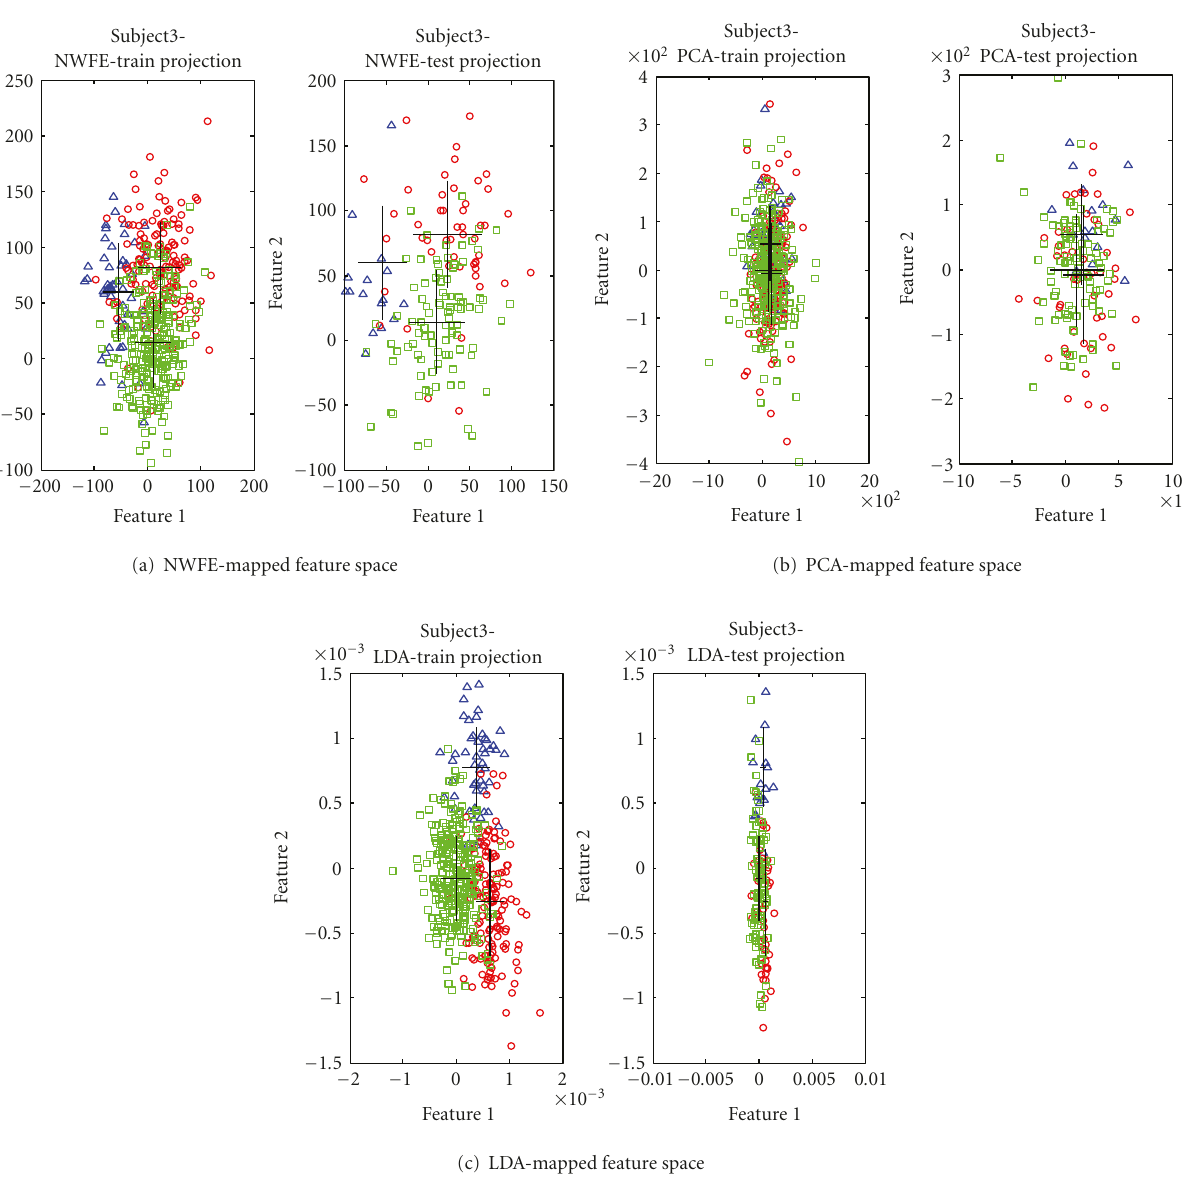
Figure 6: Scatter-plot for Subject 3 using (a) NWFE, (b) PCA, and (c) LDA